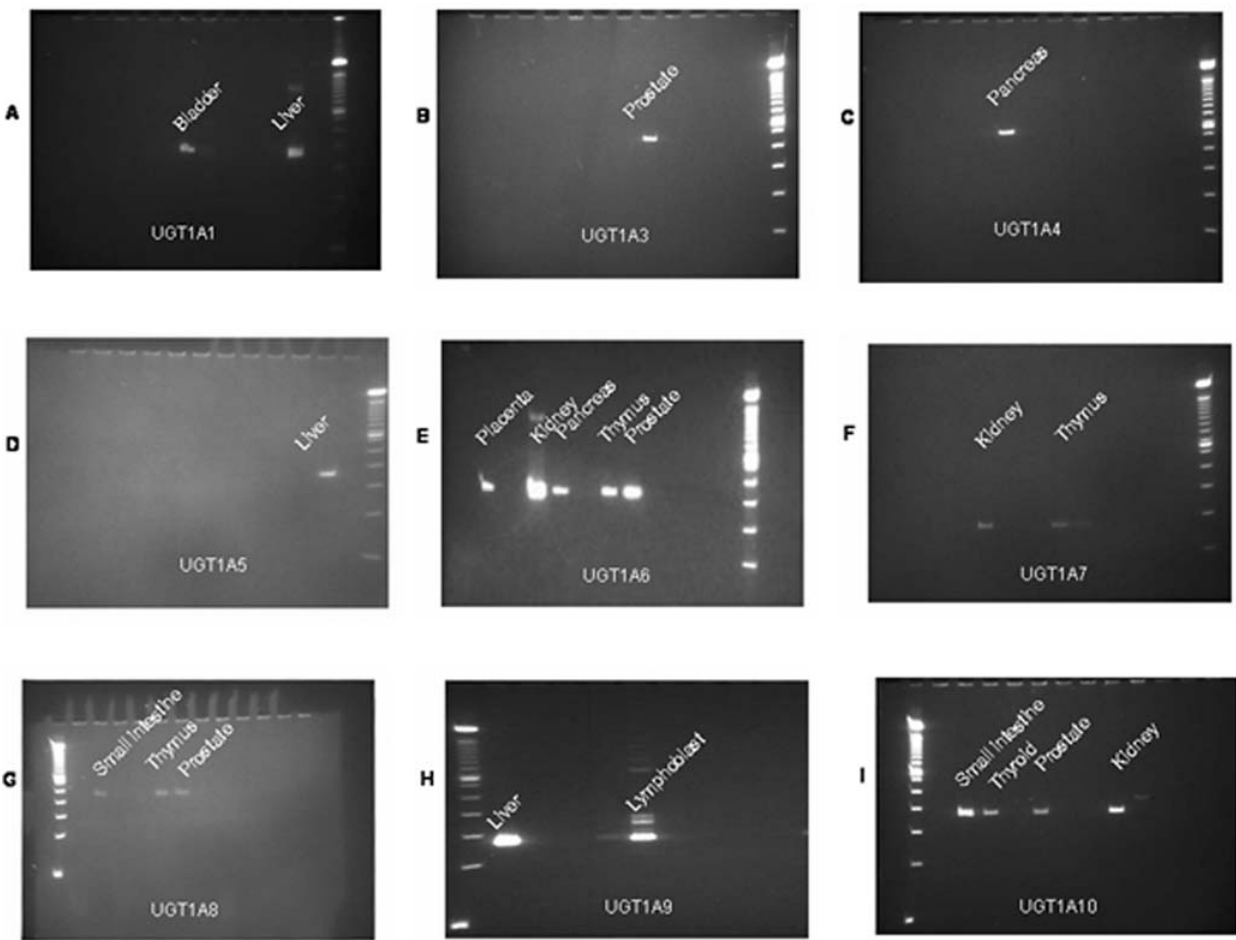
Figure 1. Expression of UGT1A isoforms among multiple human tissue samples. For each functional UGT1A isoform (A through I), an example for the PCR gels for expression in multiple human tissues together with molecular weight markers is shown.